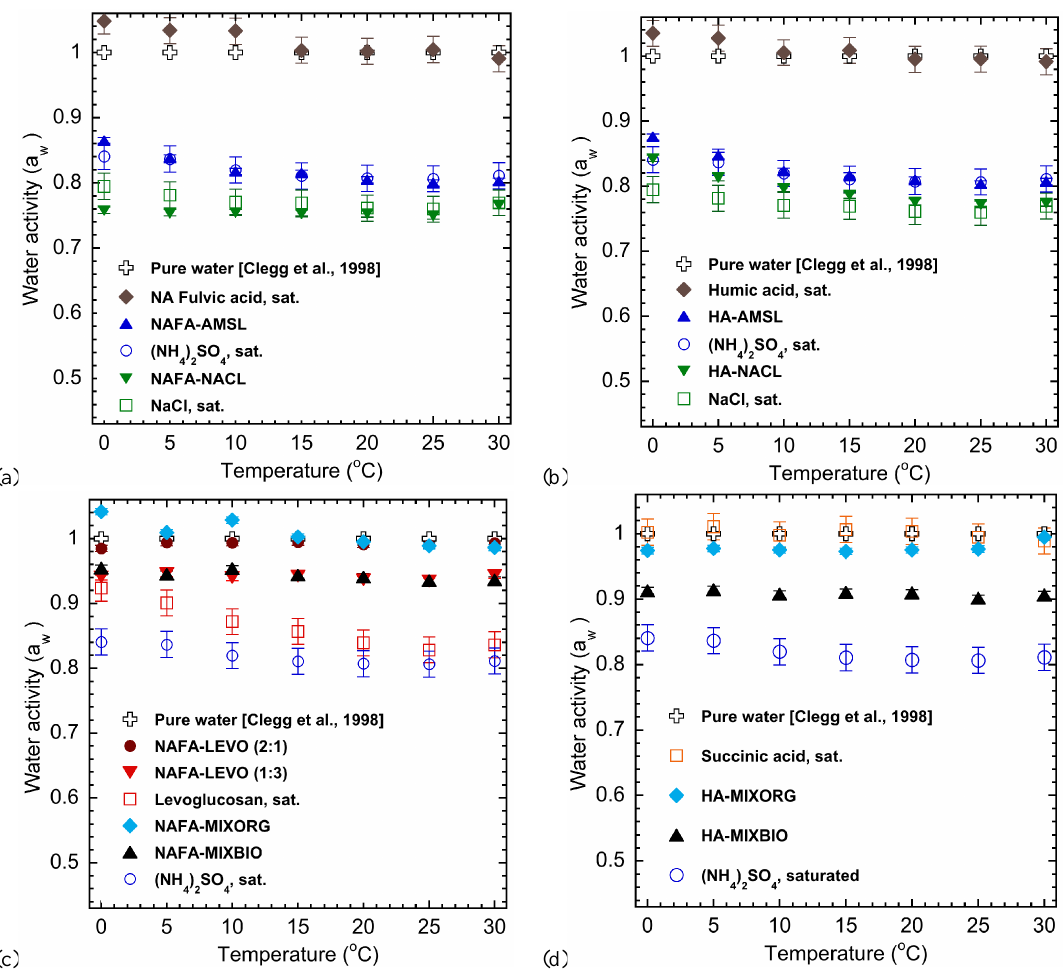
Fig. 2. Measured water activity as a function of temperature in the 0–30 ◦ C range for the most concentrated solutions made of (a) NAFA and its mixtures with inorganic salts, (b) HA and its mixtures with inorganic salts, (c) NRFA in two mixtures with levoglucosan and in mixtures MIXORG and MIXBIO, and (d) HA in mixtures MIXORG and MIXBIO. See Fig. 1 for mixture compositions. Open symbols show the curves for pure substances at saturated concentrations measured with the same method by Zamora et al.